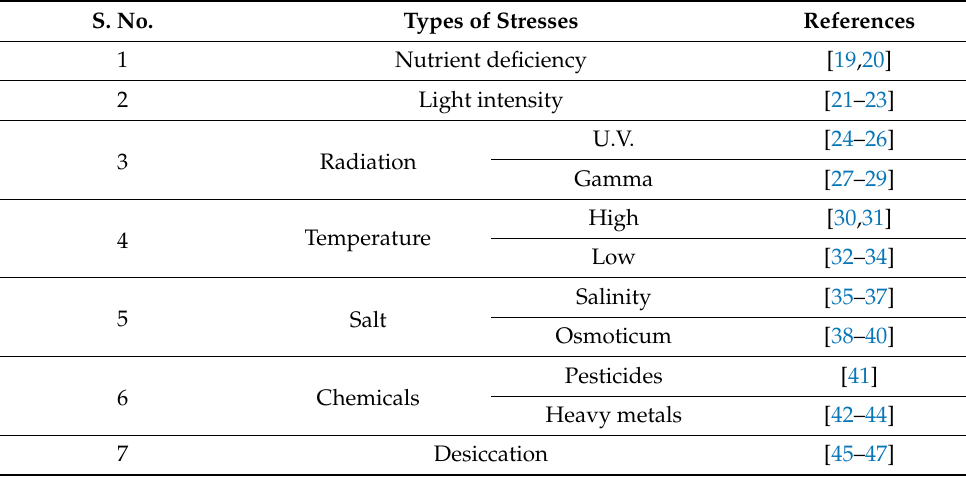
Table 1. List of abiotic stress tolerance in cyanobacteria with their references. S.